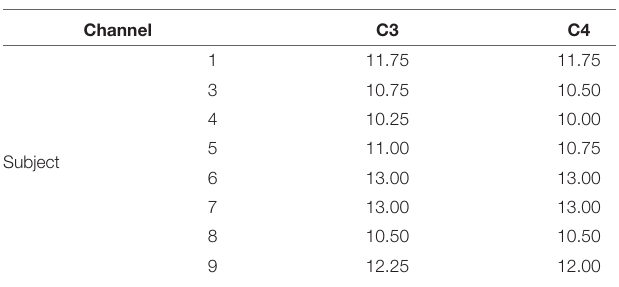
TABLE 2 | Subject specific mu